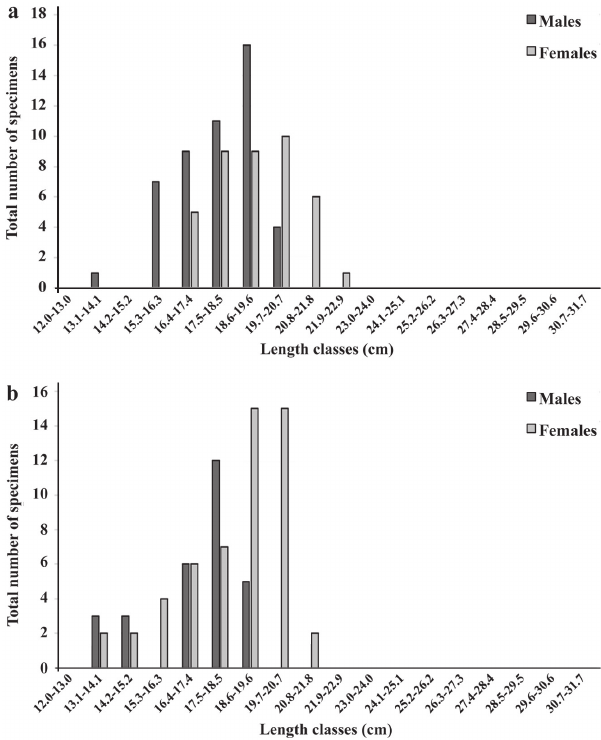
Fig. 4. Distribution of Loricariichthys melanocheilus in the rio Ibicuí by length classes for separate sexes in point 2. a: Lagoon and b: